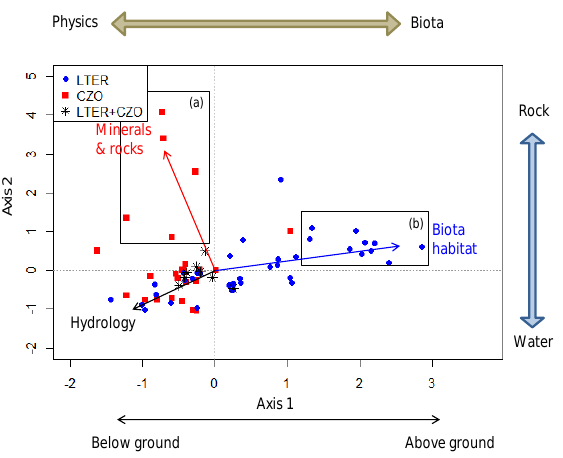
Figure 6. Ordination of the models and data in the survey; clusters show significant differences for models of LTER and CZO. CZO cluster A focuses on variables of the saprolite and bedrock; LTER cluster B focuses on the variables of biota and